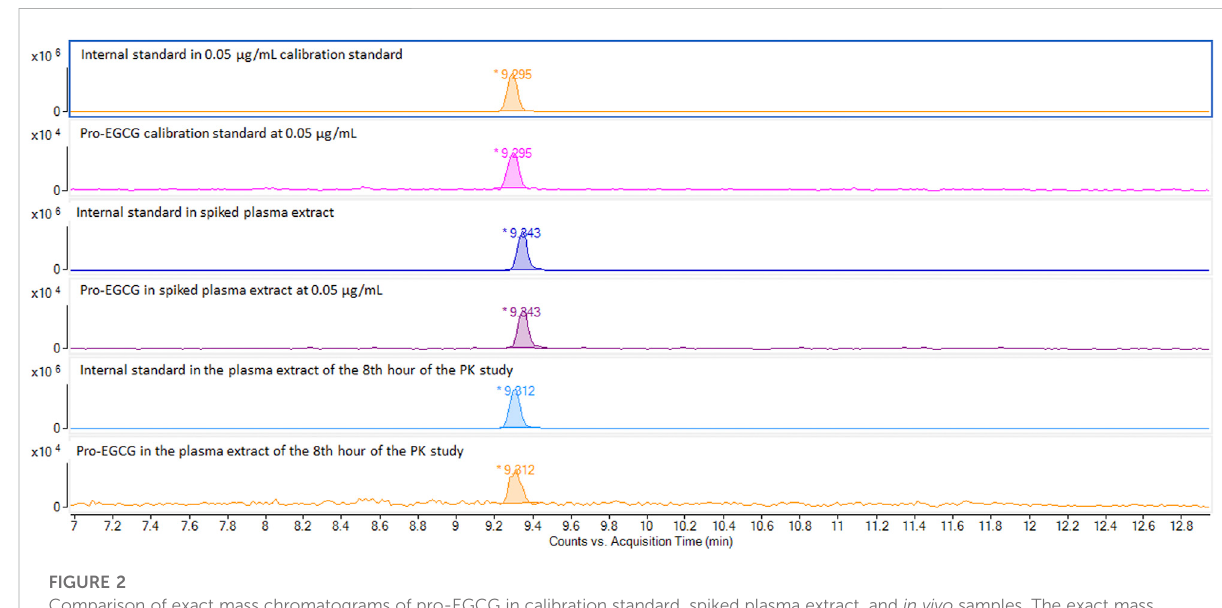
FIGURE 2 Comparison of exact mass chromatograms of pro-EGCG in calibration standard, spiked plasma extract, and in vivo samples. The exact mass chromatogram showed no interferences were detected for the calibration standard at 0.5 μ g/mL, spiked plasma samples at 0.5 μ g/mL, and in vivo plasma sample 8 h after oral administration of pro-EGCG at 50 mg/kg.